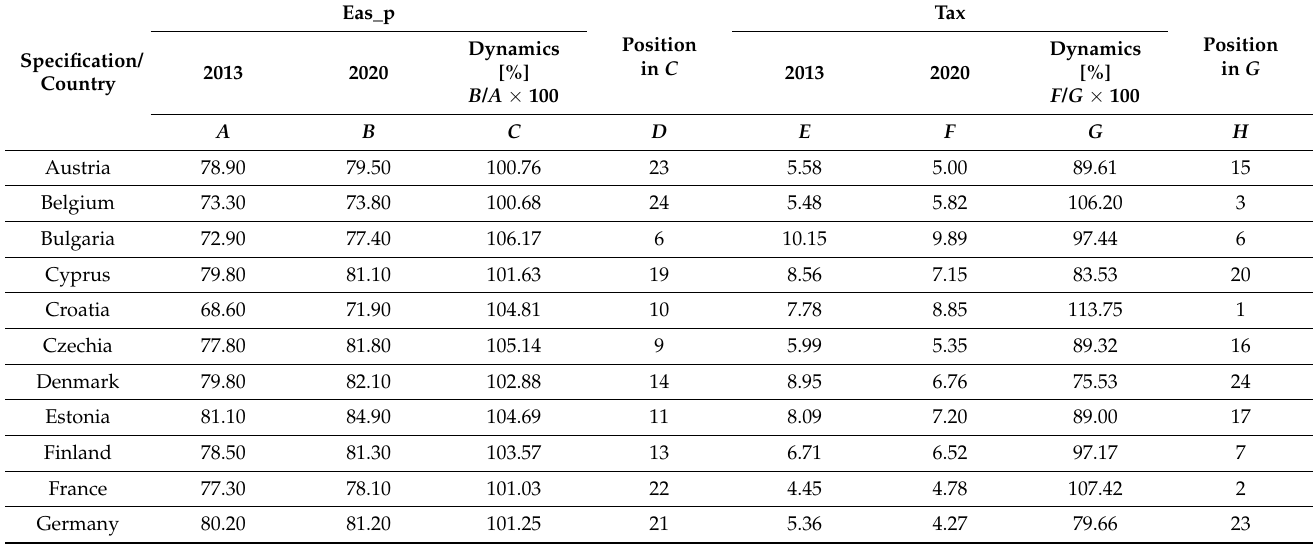
Table A4. Size of employment and labor force participation in the economy (in % of population) and share of environmental tax in % of tax revenue)—comparison 2013 and 2020 in the